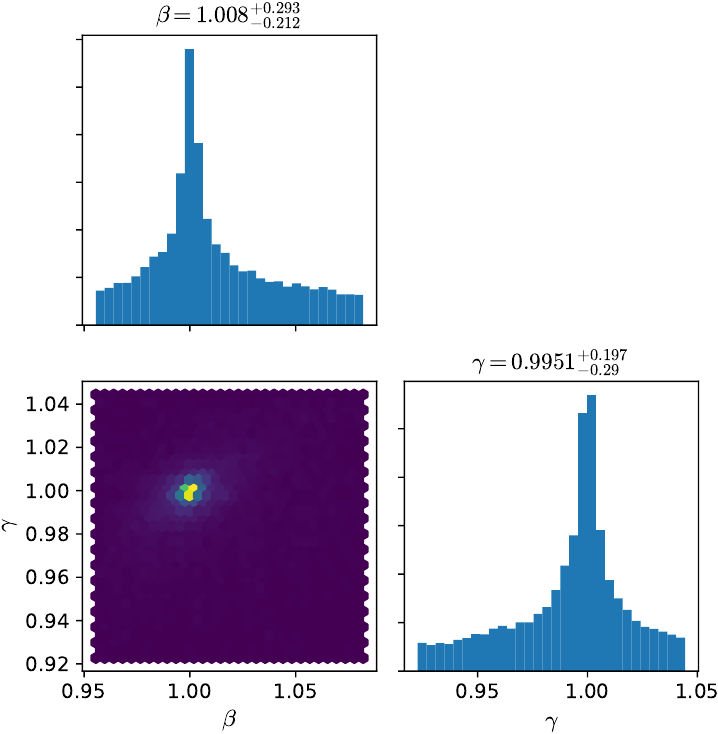
Figure 1. The posterior distribution of β PPN and γ PPN